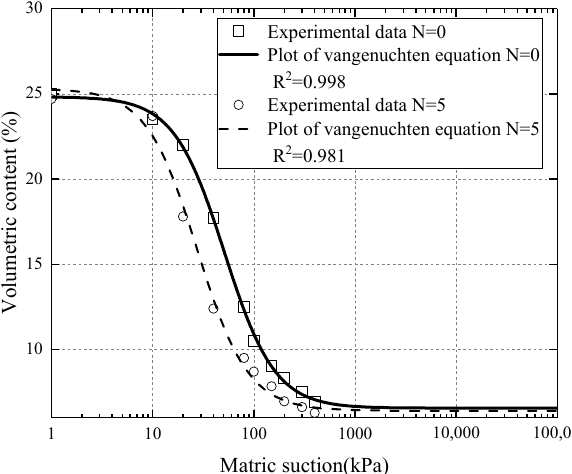
Figure 4. The SWCC of the C-M-S specimen.